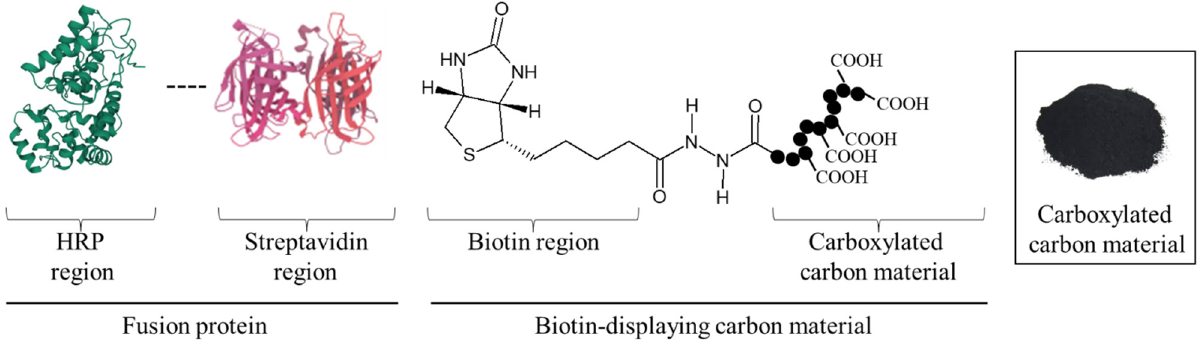
Figure 1. Concept of targeted protein-displaying system on carbon material.